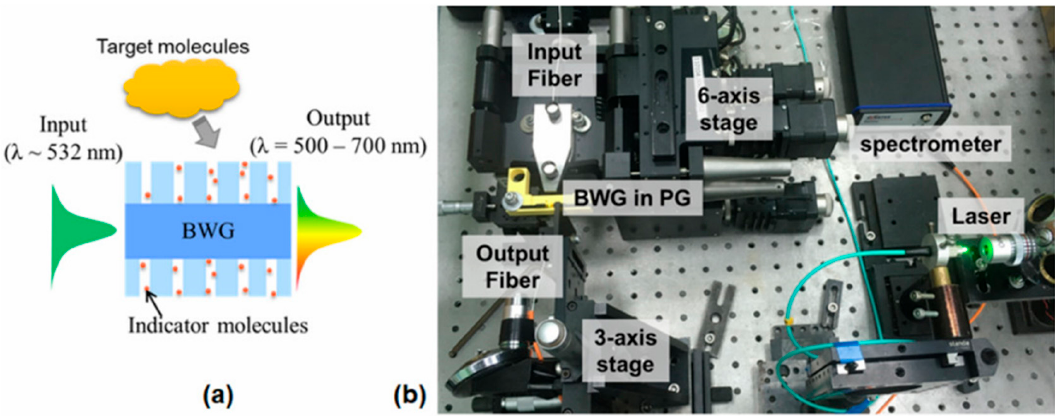
Figure 2. Scheme of the bulk waveguide (BWG) transducer concept ( a ). Experimental setup for testing the BWG transducer and the inserted photo of laser radiation coupling into the BWG by fiber-sample-fiber connection ( b ).